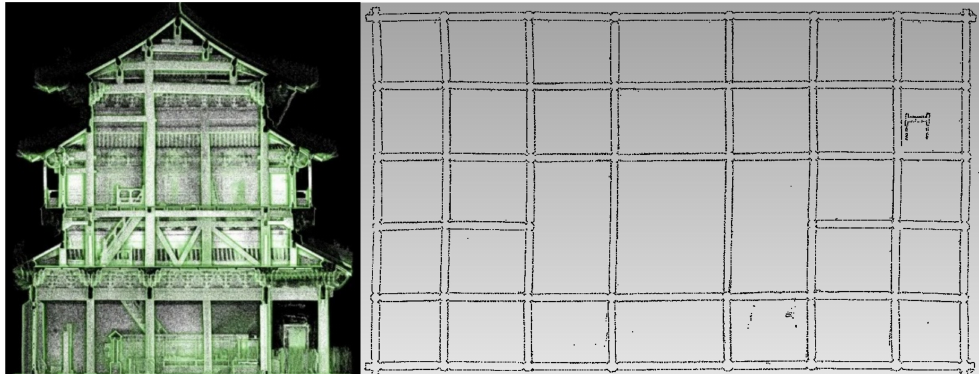
Figure 17. Deviations observed from the point cloud.